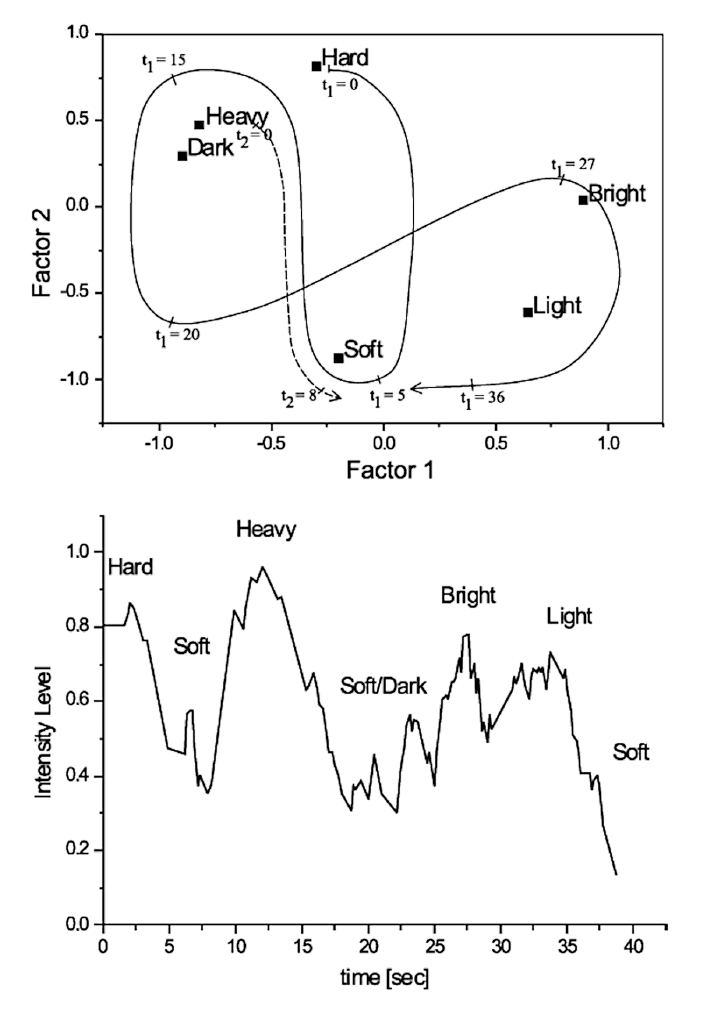
Figure 10. The control space movements and the corresponding intensity parameter trend in CaRo. Reprinted with permission from [96]. 2004,